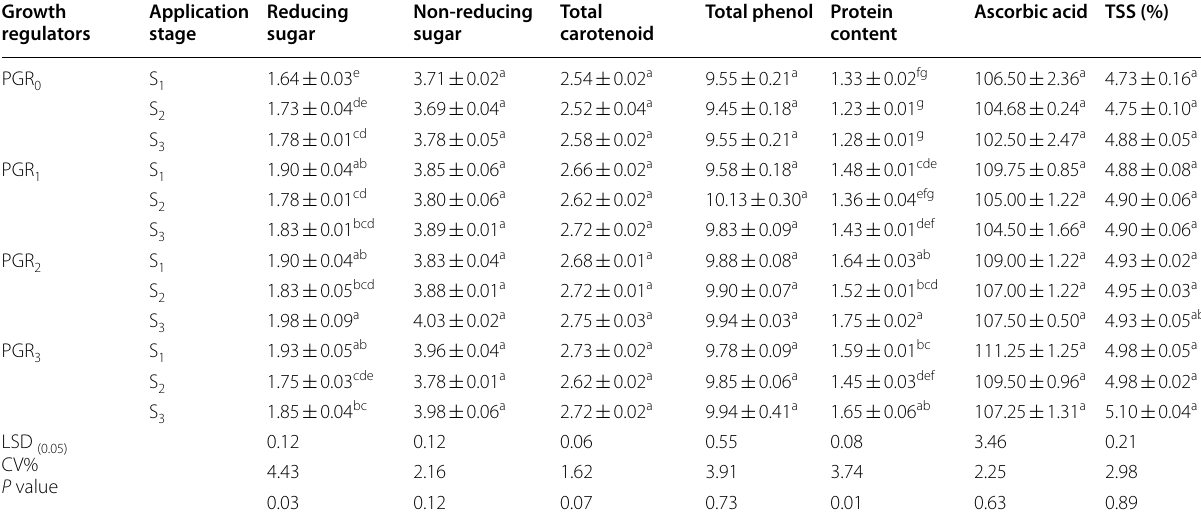
Sugar content and total phenol are expressed as mg g − 1 fresh extract, and total carotenoids, protein content and ascorbic acid as mg 100 g − 1 fresh extract. Abbreviations are as follows: PGR 0 : 0, PGR 1 : 100 mgL − 1 GA 3 , PGR 2 : 100 mgL − 1 NAA (naphthalene acetic acid) and PGR 3 : 100 mgL − 1 MH (maleic hydrazide), S 1 : seed soaking stage, S 2 : 4-leaf stage and S 3 : flower bud stage. Different letters in the same column indicate significant differences between treatments ( p < 0.05). Values are mean SE ±